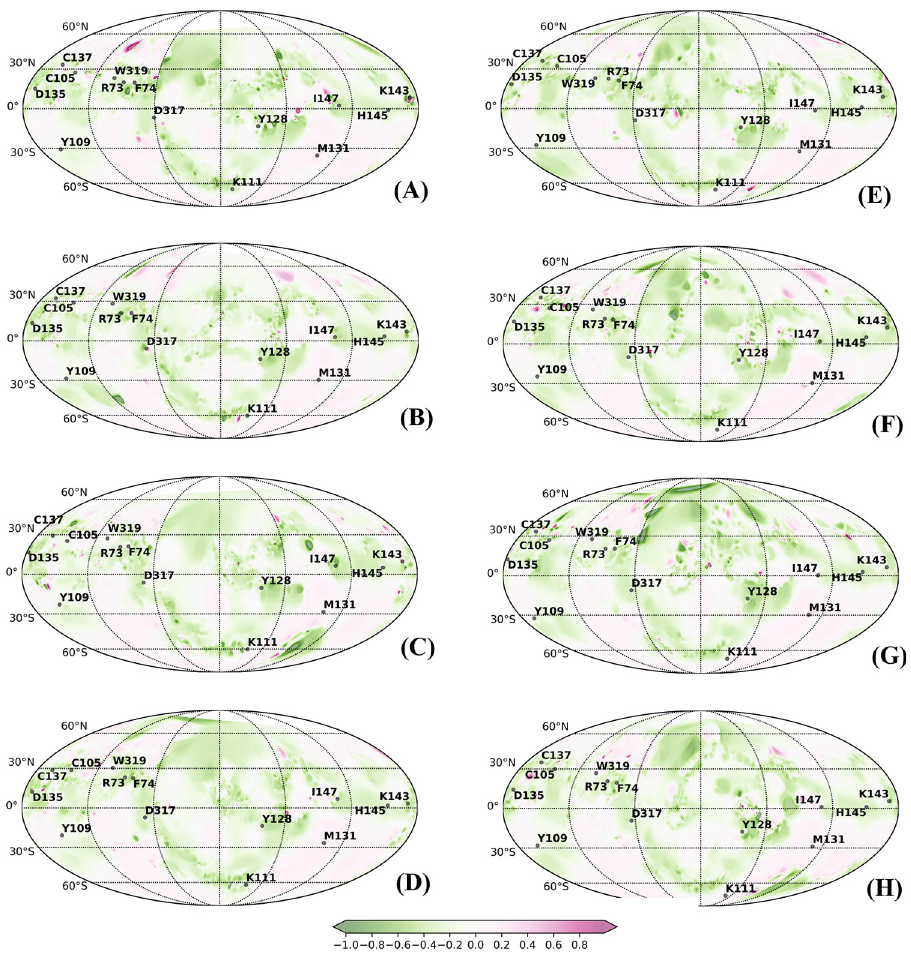
Fig 9. Protein surface topography representing molecular electrostatic potentials localized to the CRD region with fourteen key residues were mapped onto 2D spherical projections for visual comparison of free and bound forms of Calreticulin in Humans (CRTH): (A) Free_Clus1; (B) Free_Clus2; (C) Free_Clus3; (D) Free_Clus4; (E) Complex_Clus1; (F) Complex_Clus2; (G) Complex_Clus3 and (H) Complex_Clus4.